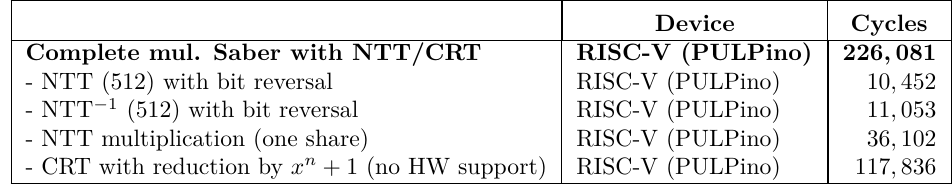
Table 3: Clock cycle count for the NTT with CRT